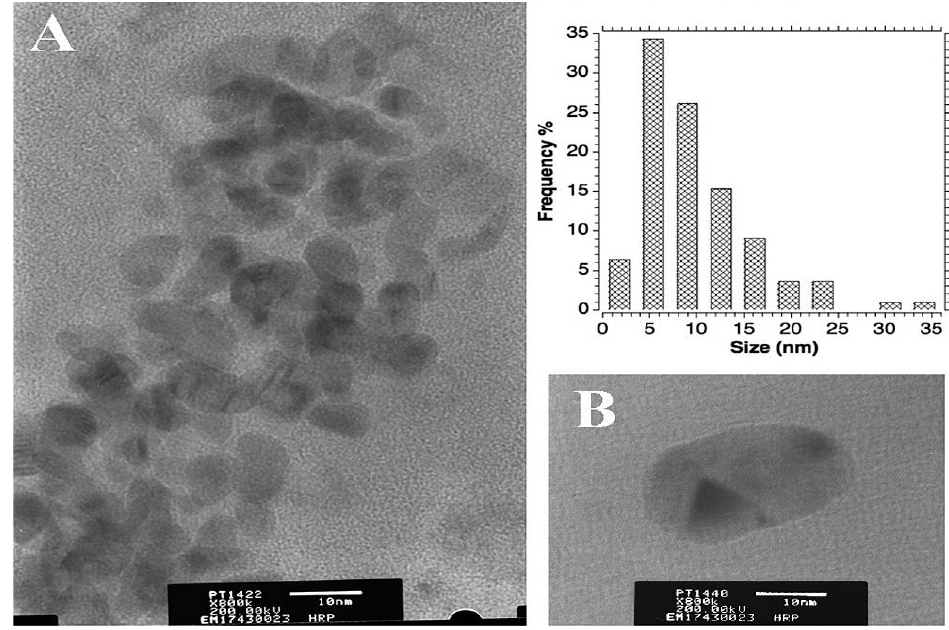
Figure 9. TEM images of ( A ) Pt nanoparticles, and ( B ) Pt nanoparticles formed sonoelectrochemically directly onto the carbon particles. Inset is the particle size distribution of the carbon supported Pt nanoparticles [17].